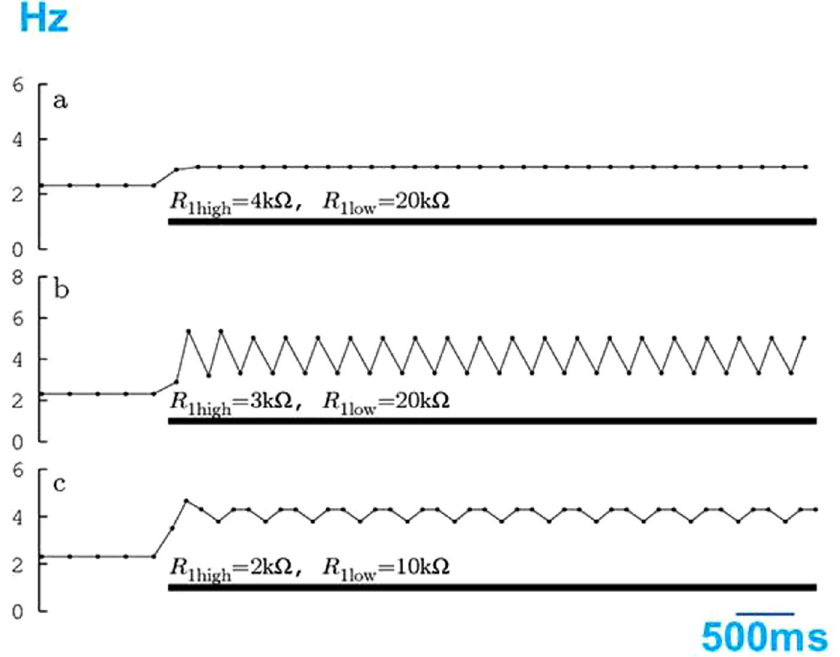
Figure 6. Dependence of the simulation results of the pulse generator on the electrode resistance. The thick bar below each trace represents the low resistance condition. ( a ) Reduction of the electrode resistance induces high-frequency oscillations and ( b ) Periodic alternations of high frequency pulse and low frequency pulse appear (alternative oscillations). ( c ) The output pulses display regular cycles every three pulses (period three